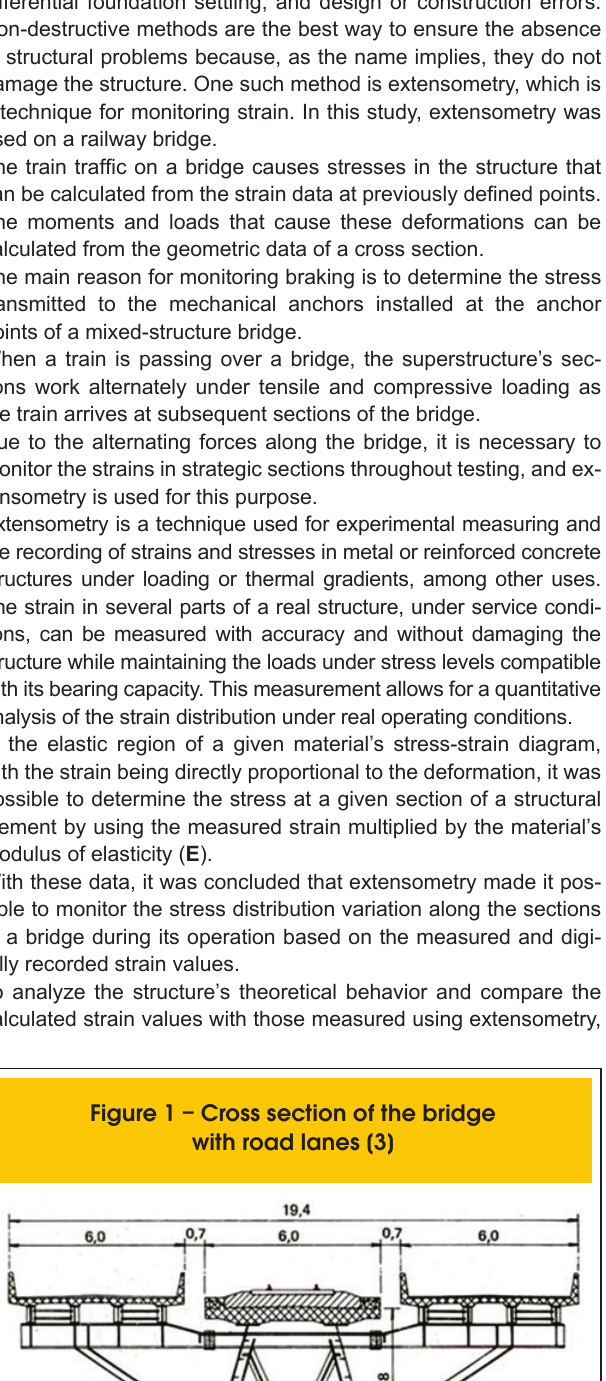
Figure 2 – General diagram of the bridge with subdivisions